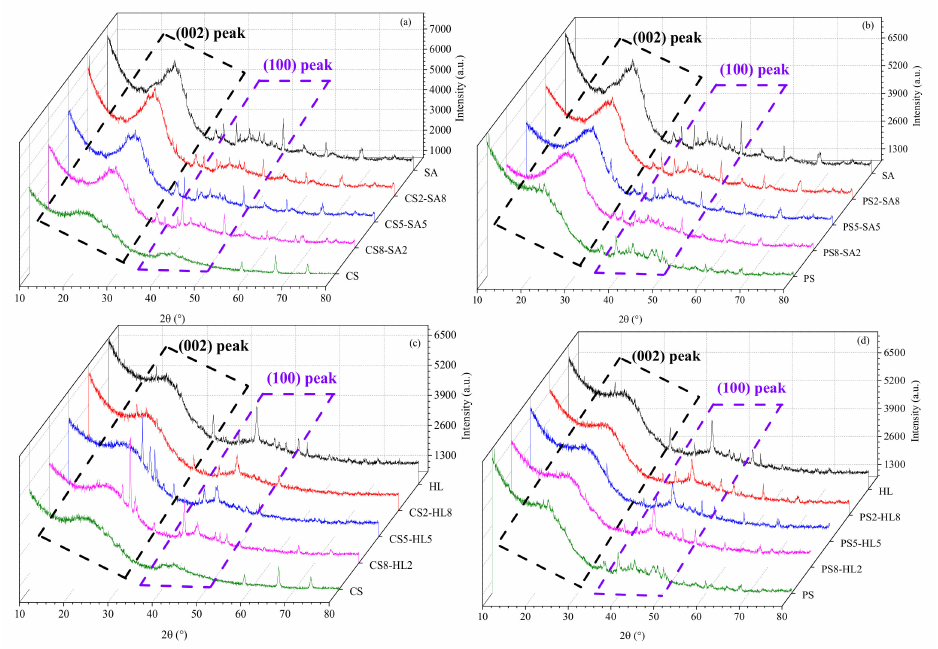
Figure 3. XRD patterns of different char samples: ( a ) SA char with different CS mass ratios, ( b ) SA char with different PS mass ratios, ( c ) HL char with different CS mass ratios, ( d ) HL char with different PS mass